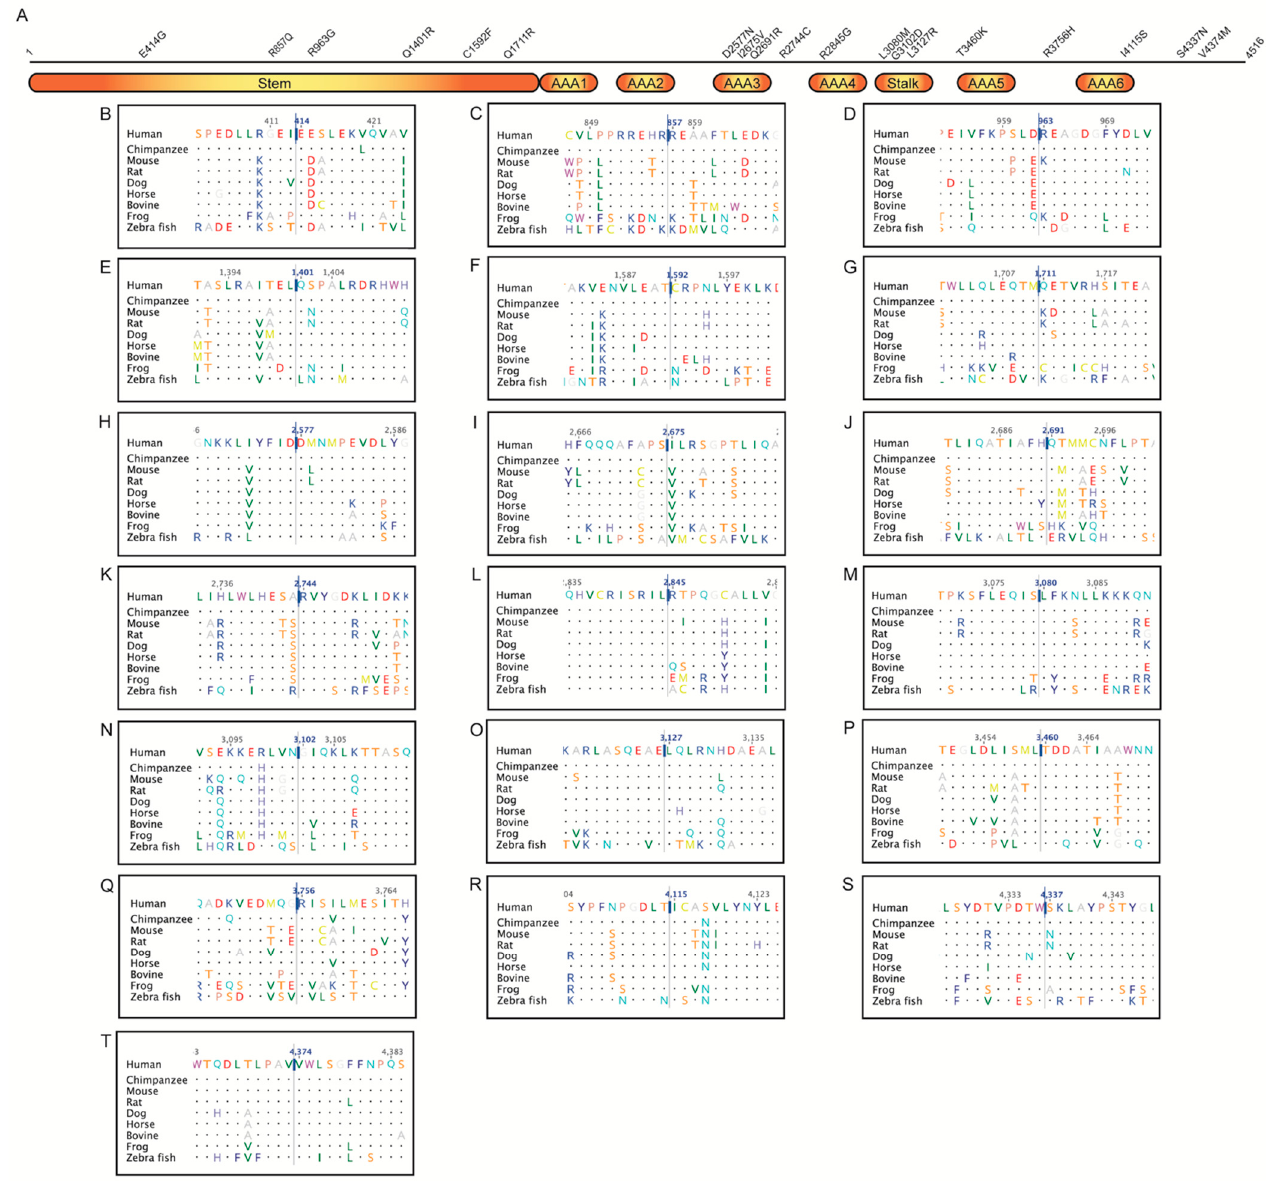
Figure 3. ( A ) Schematic representation of the DNAH11 protein (4516 amino acids). Stem, stalk, and ATPases Associated with a variety of cellular Activities (AAA) regions are shown as blocks. Missense and nonsense variations identified here are displayed above the block diagram. Twenty-one amino acid regions, centered around missense/nonsense variations, obtained from a multiple sequence alignment of DNAH11 proteins from human, chimpanzee, mouse, rat, dog, horse, bovine, frog, and zebra fish are shown in B–T–( B ) E414G (c.1241A>G); ( C ) R857Q (c.2570G>A); ( D ) R963G (c.2887A>G); ( E )